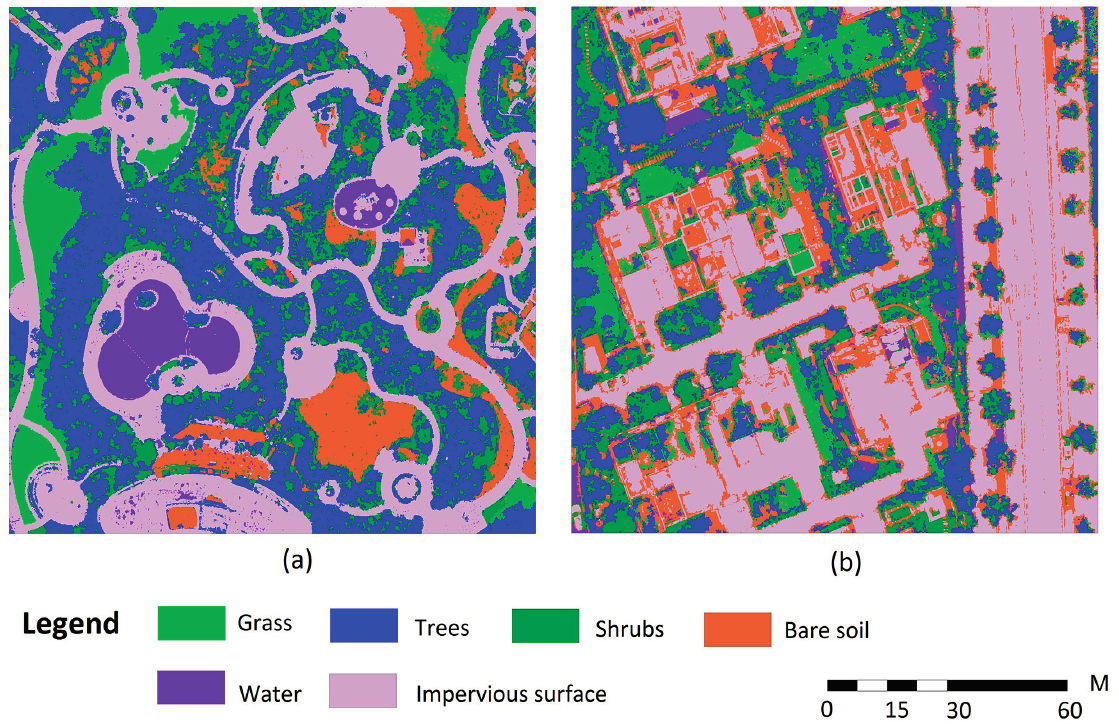
Figure 12. Classification results using OBIA. ( a ) Image-A; ( b )